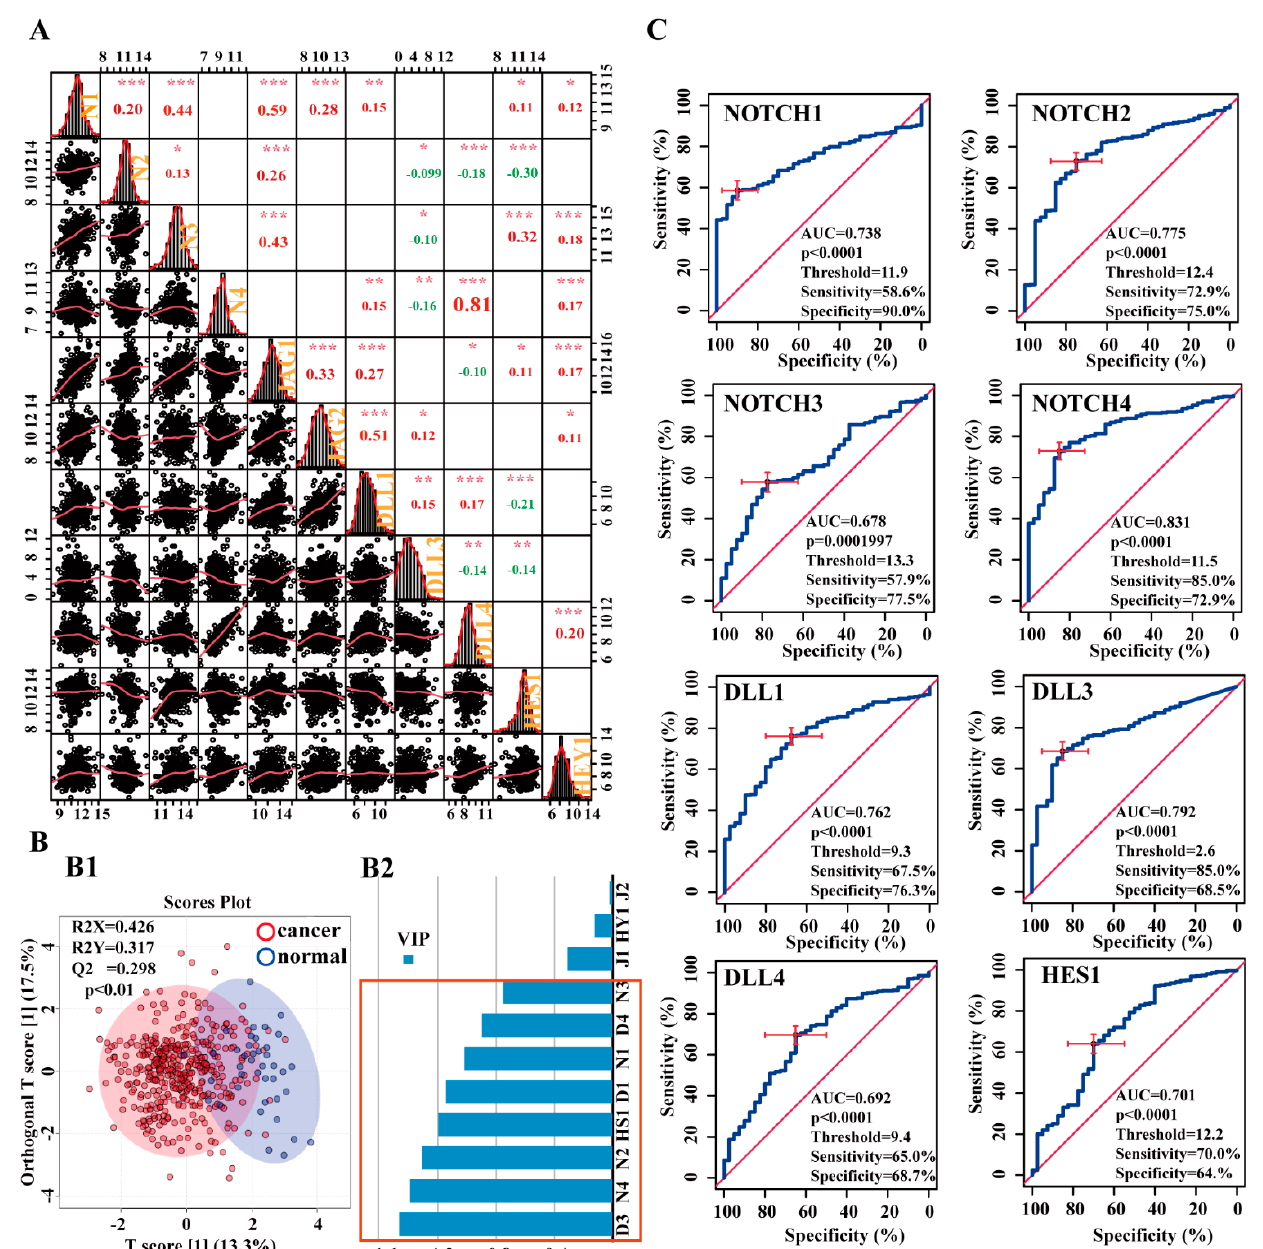
Figure 3. Correlations and diagnostic value of Notch pathway-related genes. ( A ) Correlation between the target genes in BCa ( n = 406); explanation of the histogram: (i) the histogram of the kernel density estimation and distribution of each component is shown on the diagonal; (ii) on the bottom of the diagonal: the bivariate scatter plots with a fitted line are displayed; (iii) on the top of the diagonal: the value of the correlation plus the significance level as stars; each significance level is associated to a symbol: p -values 0.001, 0.01, 0.05 relate to symbols, ***, **, *, respectively; the number in the charts is the Pearson’s correlation coefficient (r), the positive marked in red and negative marked in green; (iv) numbers at the sides of the charts indicate the range of expression values = Log 2 (read count value). N1: NOTCH1, N2: NOTCH2, N3: NOTCH3, N4: NOTCH4, D1: DLL1, D3: DLL3, D4: DLL4, J1: JAG1, J2: JAG2, HS1: HES1, HY1: HEY1. ( B ) OPLS-DA results. ( B1 ) OPLS-DA-based separation of the BCa and controls. ( B2 ) VIP of each feature from OPLS-DA. ( C ) Representative ROC curves showing the diagnostic accuracy (AUC) of BCa detection on the basis of NOTCH1, NOTCH2, NOTCH3, NOTCH4, DLL1, DLL3, DLL4, and HES1; the red cross marked in ( C ) is the best threshold position/value.